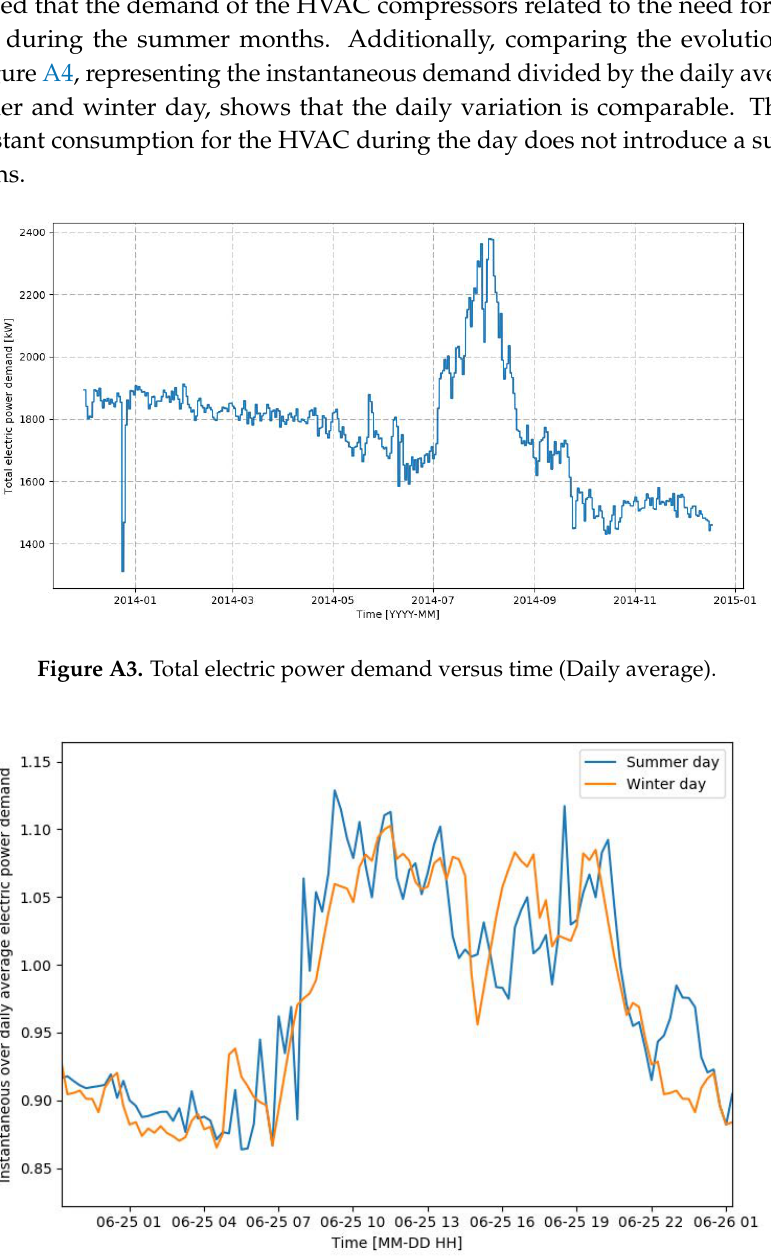
Figure A4. Instantaneous power demand over daily average, winter versus summer